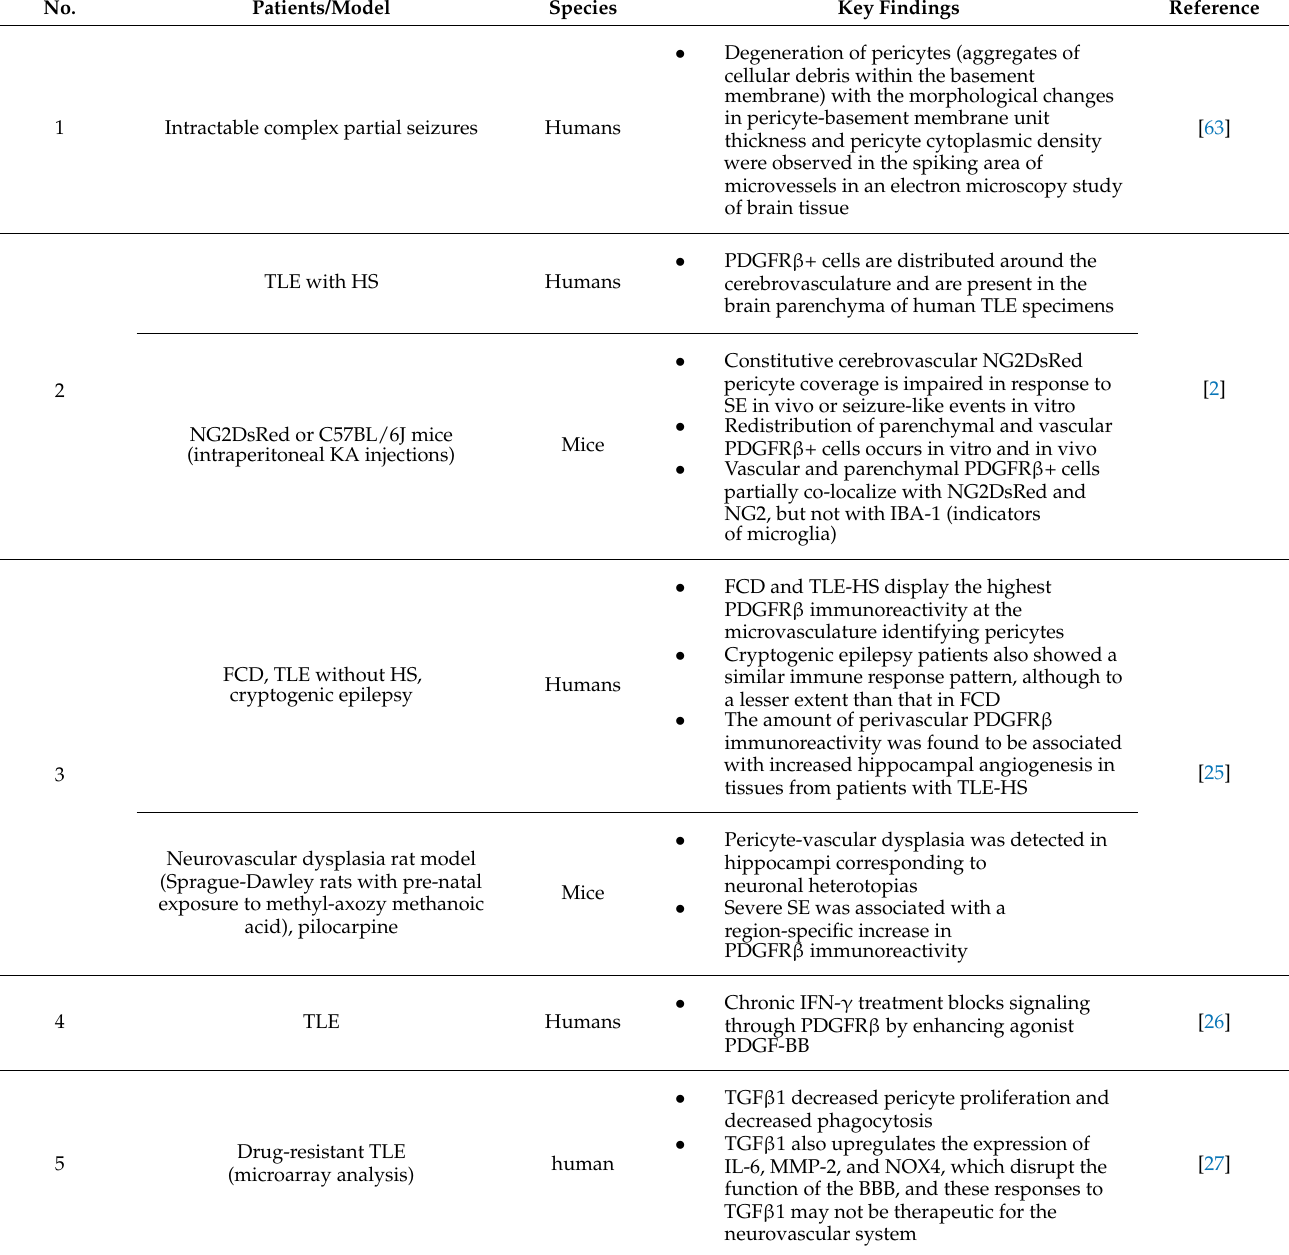
Table 2. Research and key findings on pericytes and